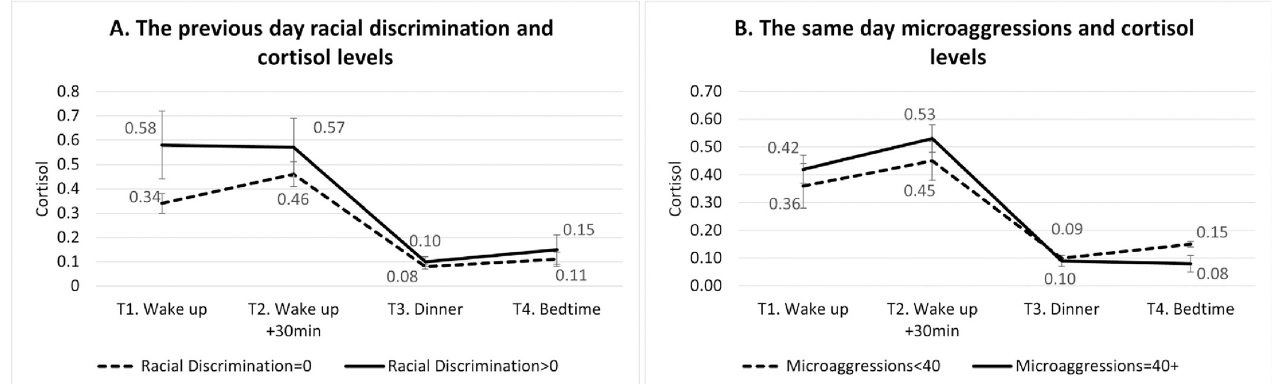
Fig 1. Mean cortisol level by the previous day racial discrimination and the same day microaggressions. (A) The previous day racial discrimination and cortisol levels (B) The same day microaggressions and cortisol levels. Note: Participants reported on average 0.61 overt racial discrimination experiences per day and most reported substantial daily microaggression